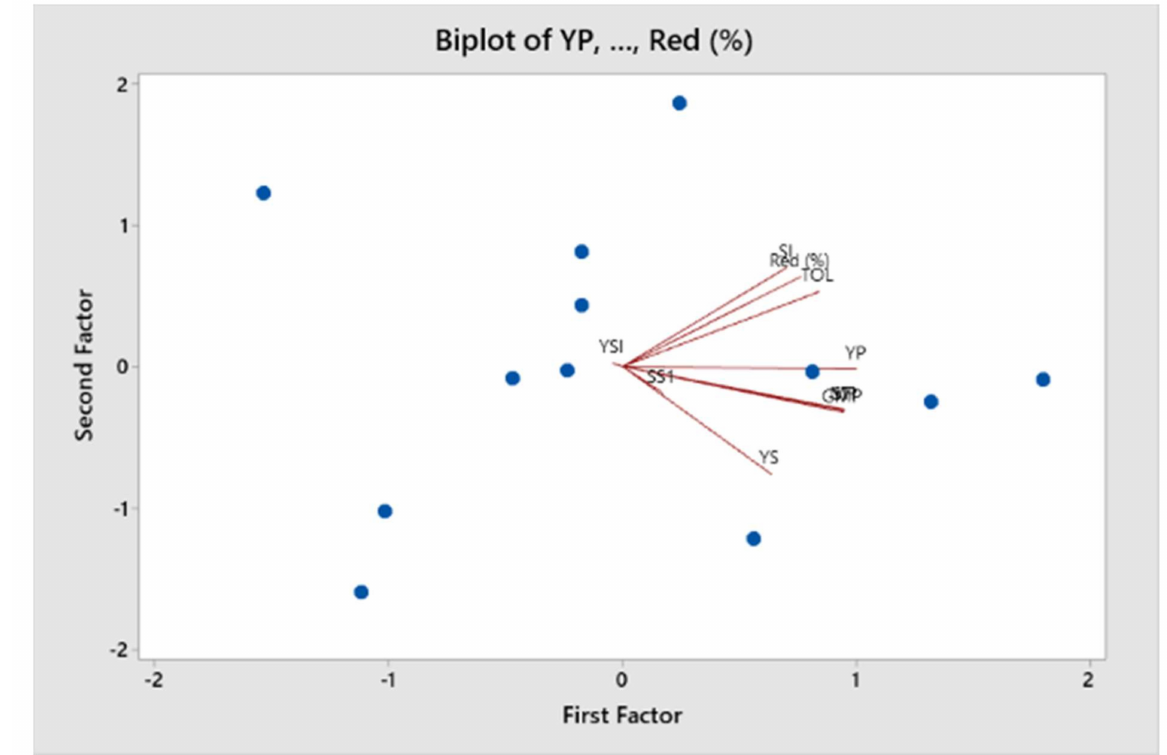
Figure 2. Biplot diagram of PCA of genotype yield under well-watered (YP) and water-stressed conditions